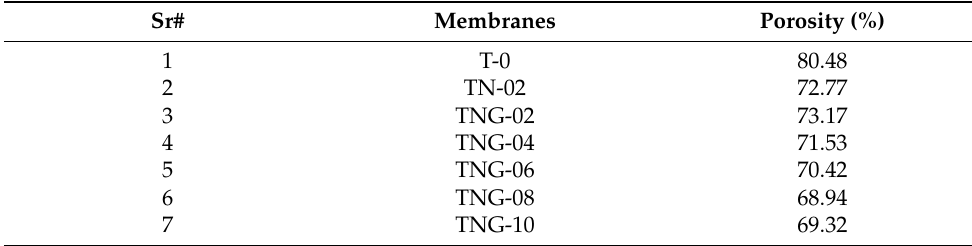
Table 2. Porosity (%) of TPU based NiO/NH 2 -GO membranes.